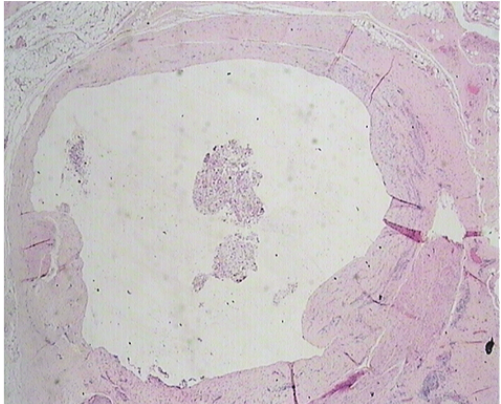
Figure 2: Apoptosis of papillae into the cyst lumen (H&E × 20).